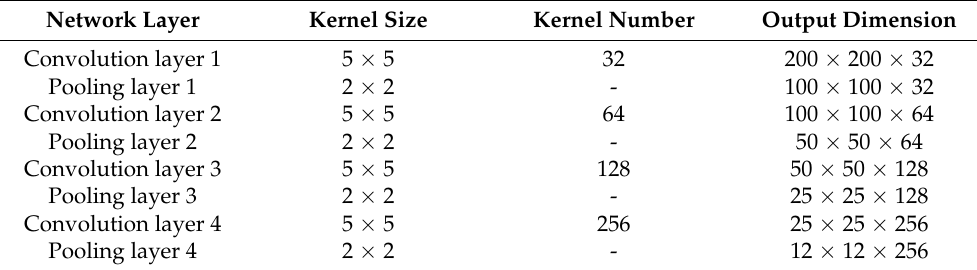
Table 5. The former part of the MCNN parameters. Network Layer Kernel Size